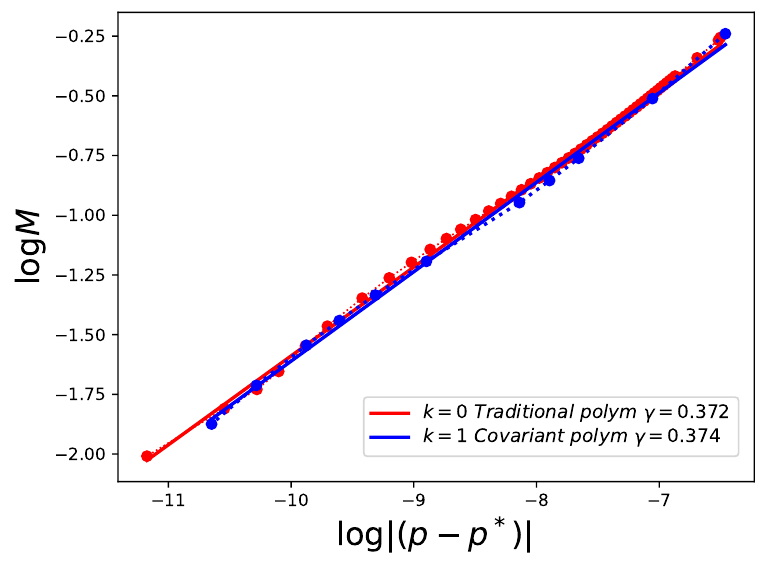
Figure 1. The scaling of the black hole mass observed first by Choptuik [12] for the collapse of spherically symmetric massless scalar field. Here we depict it for general relativity ( k = 0). The other curve is for the polymerization parameter value k = 1, which in practice is a very exaggerated value, in order to make any possible discrepancies with classical general relativity more visible. Here, γ is the universal exponent for the mass law of the black hole (see [11]). As can be seen, both theories agree. The dots are numerical results and the solid lines are least square